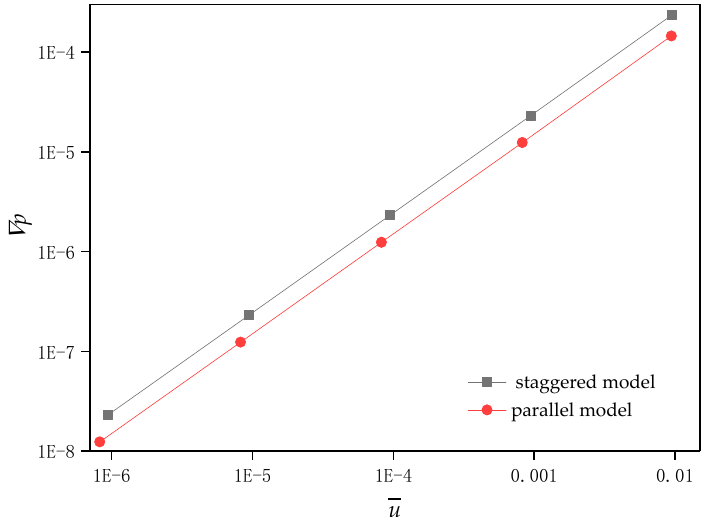
Figure 17. The relationship between pressure gradient and mean velocity of parallel and staggered structures.